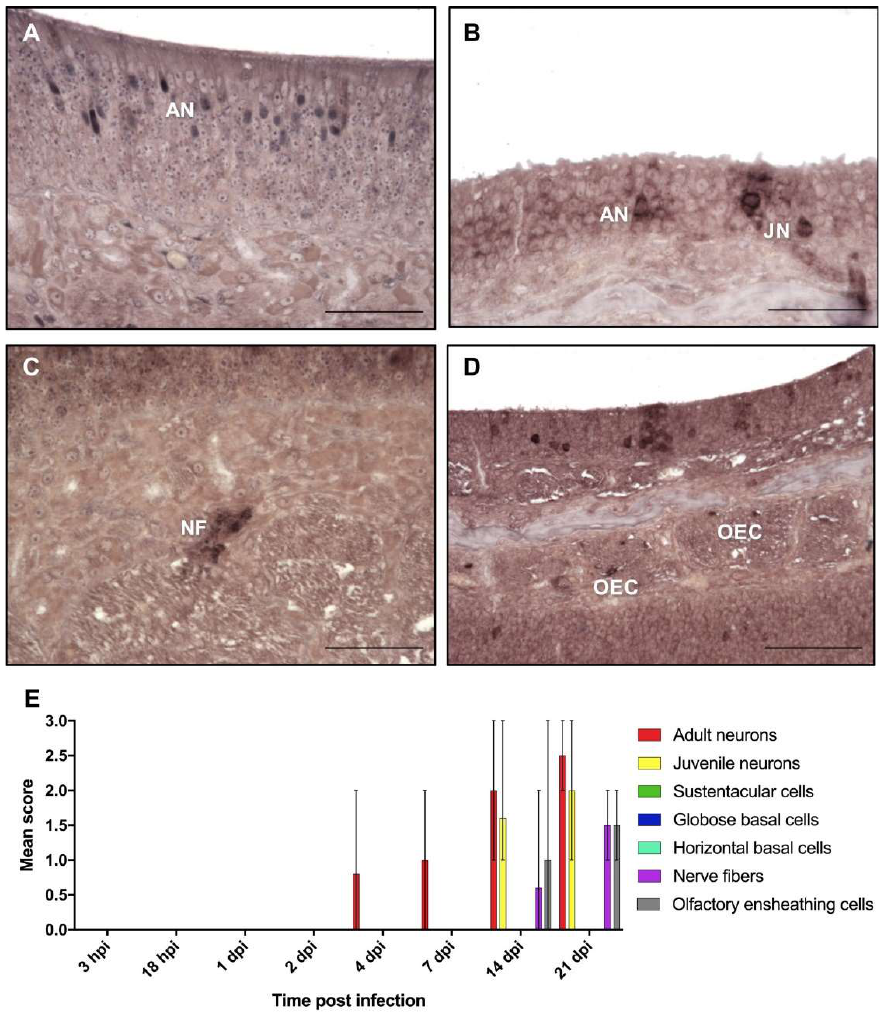
Figure 3. In situ hybridization for the detection of messenger RNA in the olfactory mucosa. At ( A ) 4 dpi; ( B ) 14 dpi; ( C ) nerve fibers located in the lamina propria at 21 dpi; ( D ) 21 dpi. AN—adult neurons; JN—juvenile neurons; NF—nerve fibers; OEC—olfactory ensheathing cells. Scale bar ( A – D ): 50 µ m. ( E ) Mean score of in situ hybridization: arithmetic mean; error bars: